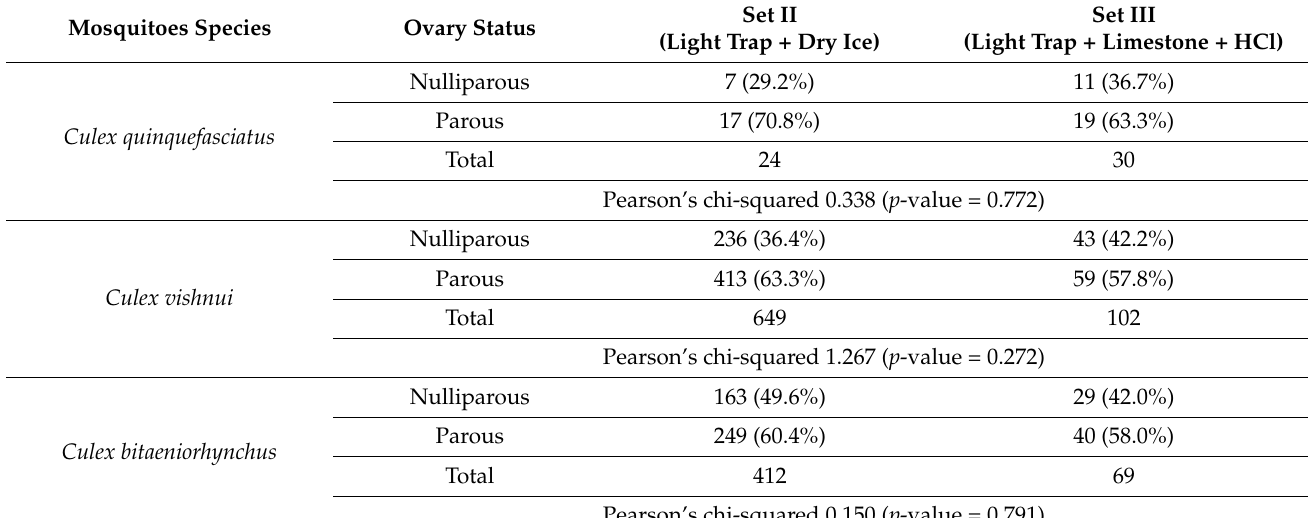
Table 3. Parity rate of Culex quinquefasciatus , Cx. vishnui and Cx. bitaeniorhynchus collected from trap Set II and trap Set